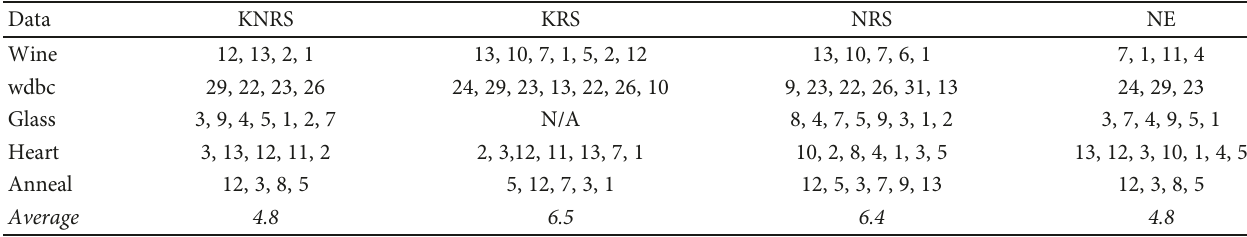
Table 5: Subsets of the features selected with KNRS, KRS, NRS, and NE.